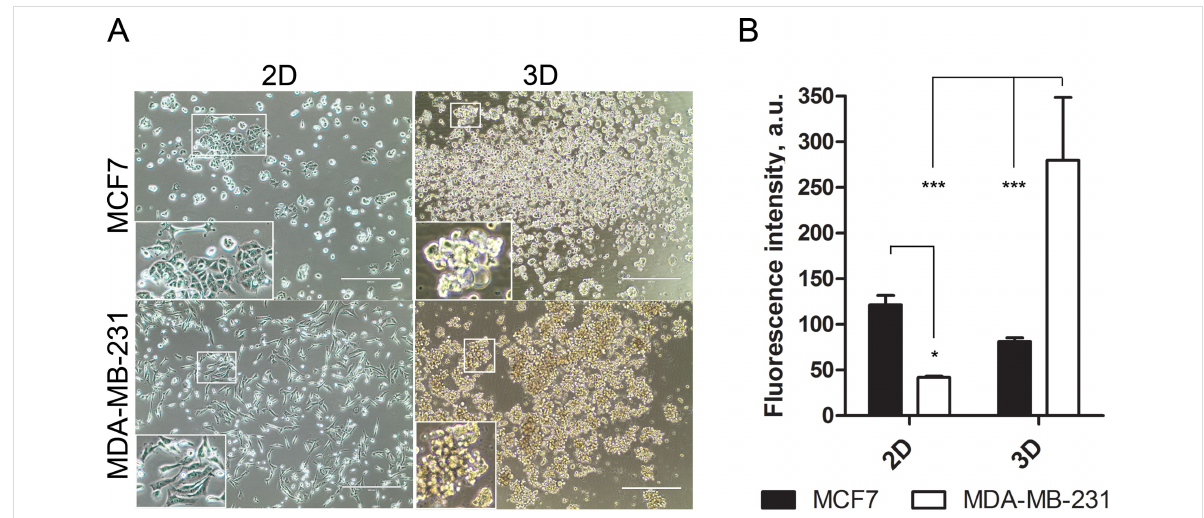
Figure 4: Comparison of MCF7 and MDA-MB-231 properties in 2D and 3D culture conditions. (A) The morphology of MCF7 and MDA-MB-231 cells in 2D and 3D culture. Scale bar – 400 μ m. (B) Quantum dot (QD) uptake efficiency in MCF7 and MDA-MB-231 cells in 2D and 3D culture expressed as the intracellular QD fluorescence intensity. * p -value < 0.05, *** p -value < 0.001.